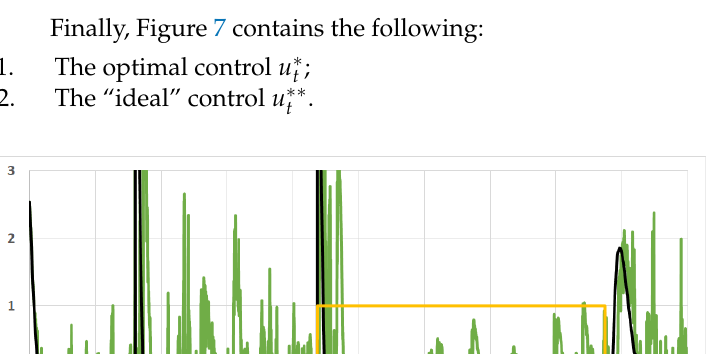
( 0 ) , 2 − v me , 3 − v ∗ t , 4 − v ∗∗ t , and 5 − target C y t . t t